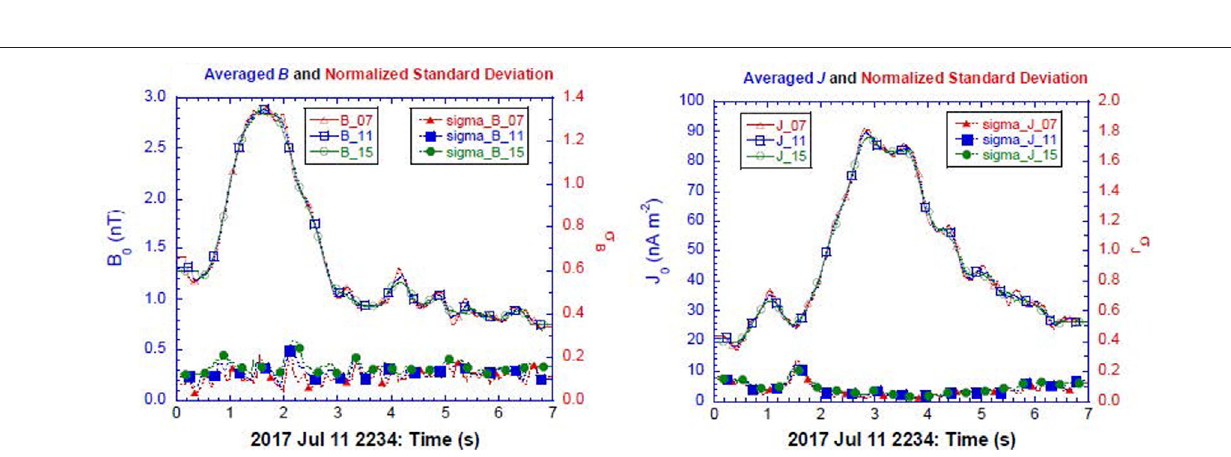
FIGURE2| Mean and normalized standard deviation fi elds derived fromthe MMS measurements. Themeans and standard deviations arecalculatedon amoving window with a width of 7 (red), 11 (blue), and 15 (green) time steps, respectively. Panels (A) and (B) correspond to the B fi eld and J fi eld, respectively.